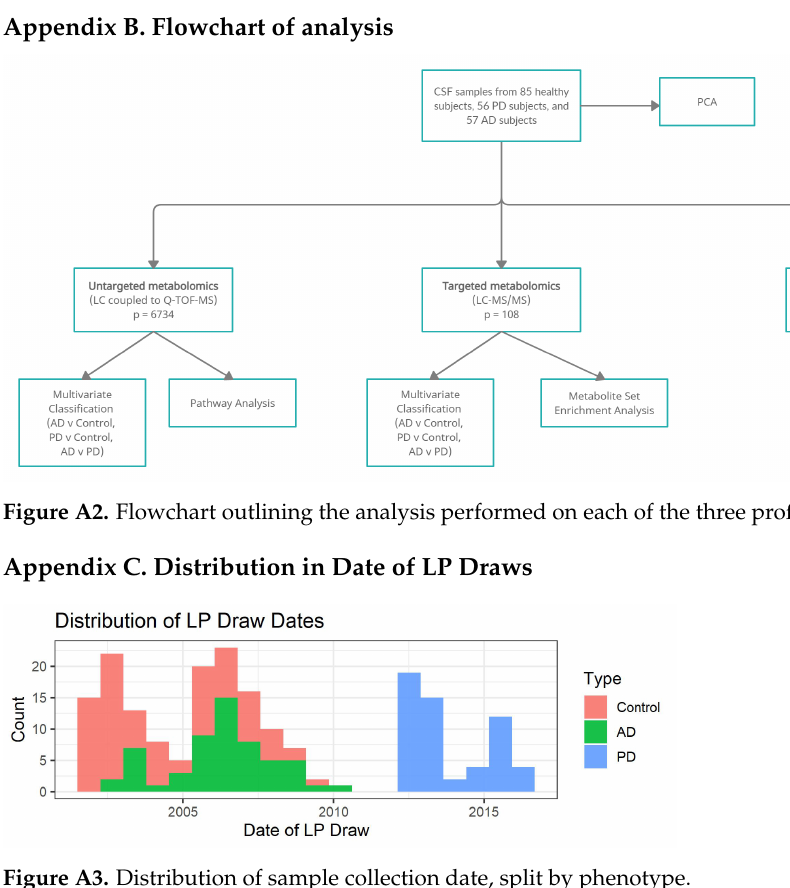
Figure A3. Distribution of sample collection date, split by phenotype.